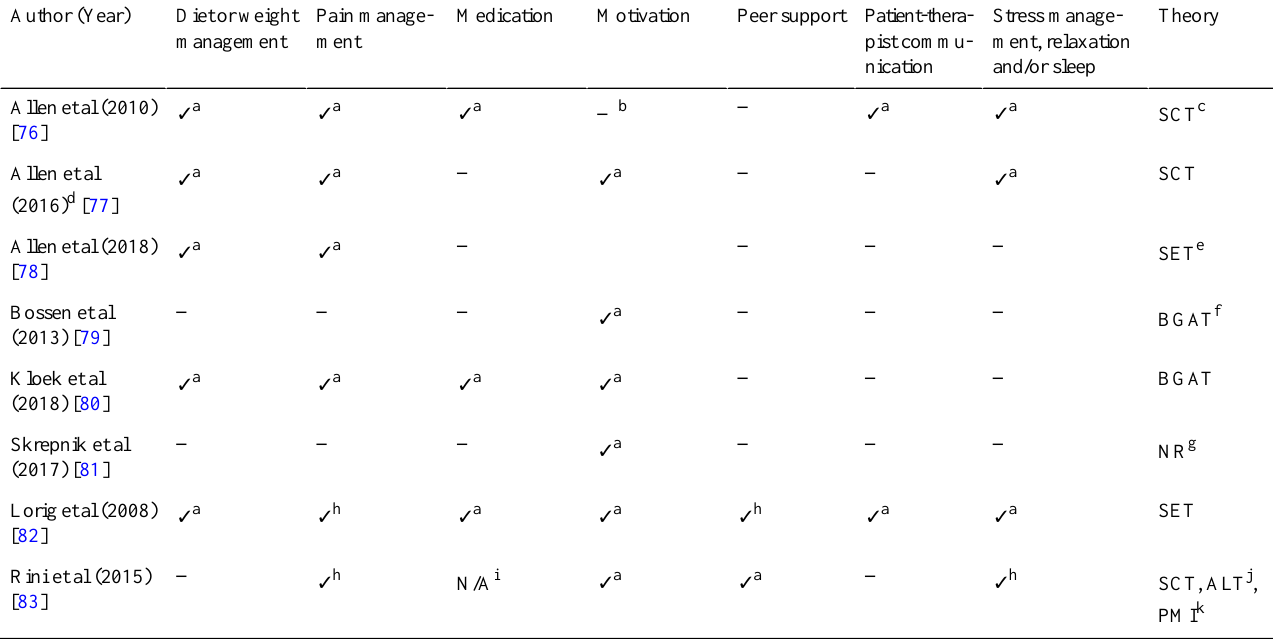
Table 5. Detailed self-management program components (continued).